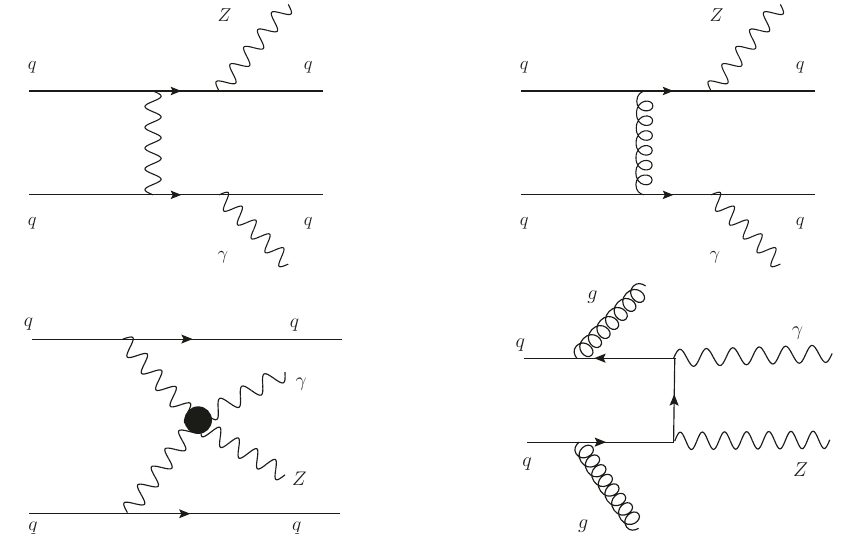
Figure 1 . Feynman diagrams of electroweak Z(cid:13)jj production involving VBS subprocesses (bottom left) or non-VBS subprocesses (top left) and of QCD Z(cid:13)jj production with gluon exchange (top right) or radiation (bottom